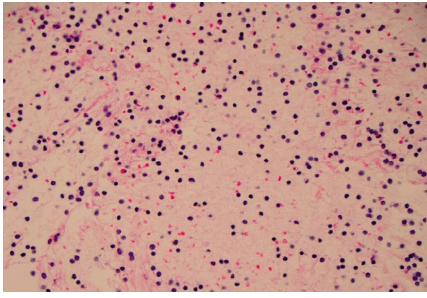
Figure 2: Histology slide for CLL.